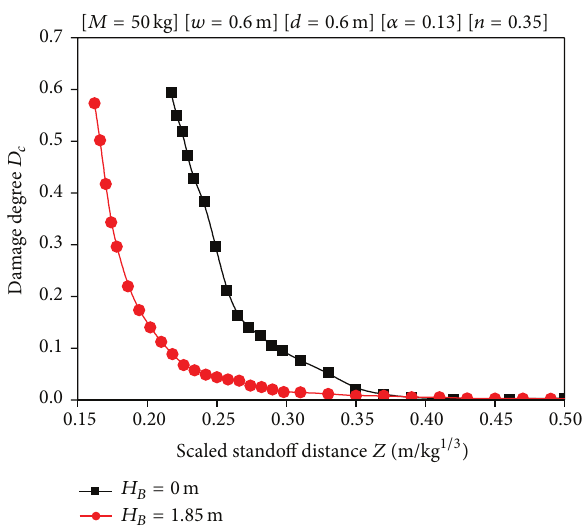
that, compared with increasing the column width, increment of the column depth is more effective in reducing the column damage degree. This is because enlarging the column width simultaneously results in a rise of blast loads acting on the column, which balances out the enhancement of column blast resistance to some